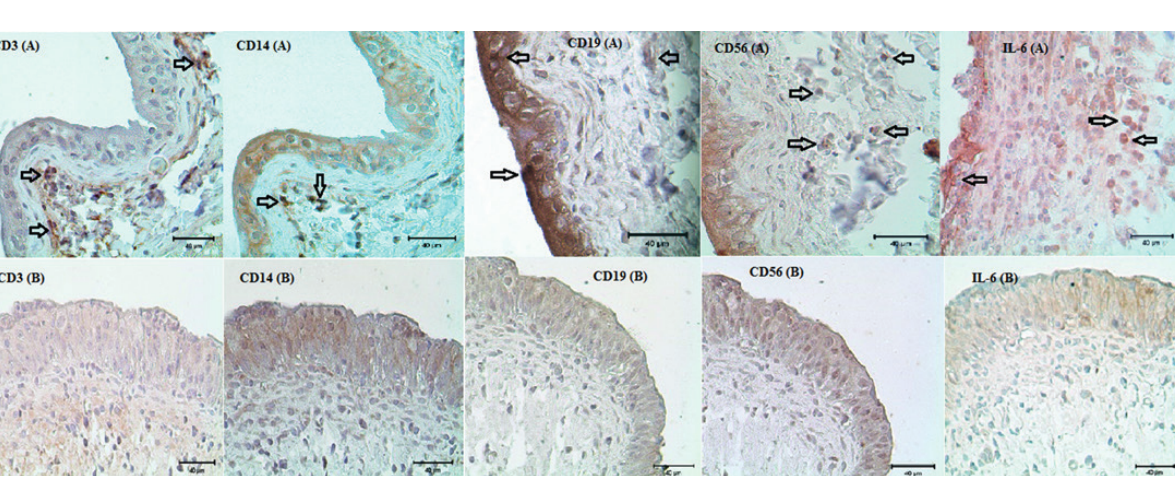
figure 1 - Images representing immunohistochemical staining of cD3, cD14, cD19, cD56 and IL-6 in Hcl group (A) and Hcl-HA group (B). Black arrows indicate stained infl ammatory cells. It is observed that infl ammatory cell infi ltration is more common in stroma and smooth muscle.